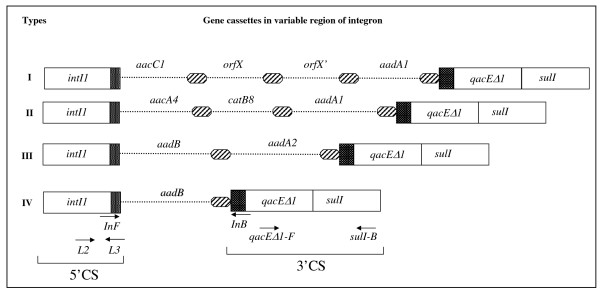
Schematic representation of different types of gene cassettes identified in the Class 1 integrons in A. baumannii strains. Dotted lines represent the gene cassettes, oval circles the 59-base elements. The attI recombination site is shown by the hatched box. Locations of the 5'CS and 3'CS of class 1 integrons and those of the primer pairs, qacEΔ1-F, Sul1B and in-F (5'CS), in-B (3'CS), are shown in the bottom panel. Different types of variable region were found in our collection of isolates: Type I: accC1-orfX-orfX'-aadA1; n = 3, Type II: aacA4-catB8-aadA1, n = 26, Type III: aadB-aadA2; n = 3 and Type IV: aadB; n = 1. accC1 (3-N-aminoglycoside acetyltransferase) and aadB (2'-O-adenylyltransferase) confers gentamicin resistance, aadA1 and aadA2 (adenyltransferase) confers resistance to spectinomycin and streptomycin, aacA4 (6'-N-acetyltransferase) confers resistance to amikacin, netilmicin and tobramycin, catB8 (chloramphenicol acetyltransferase) confers resistance to chloramphenicol. The diagram was not drawn to scale.